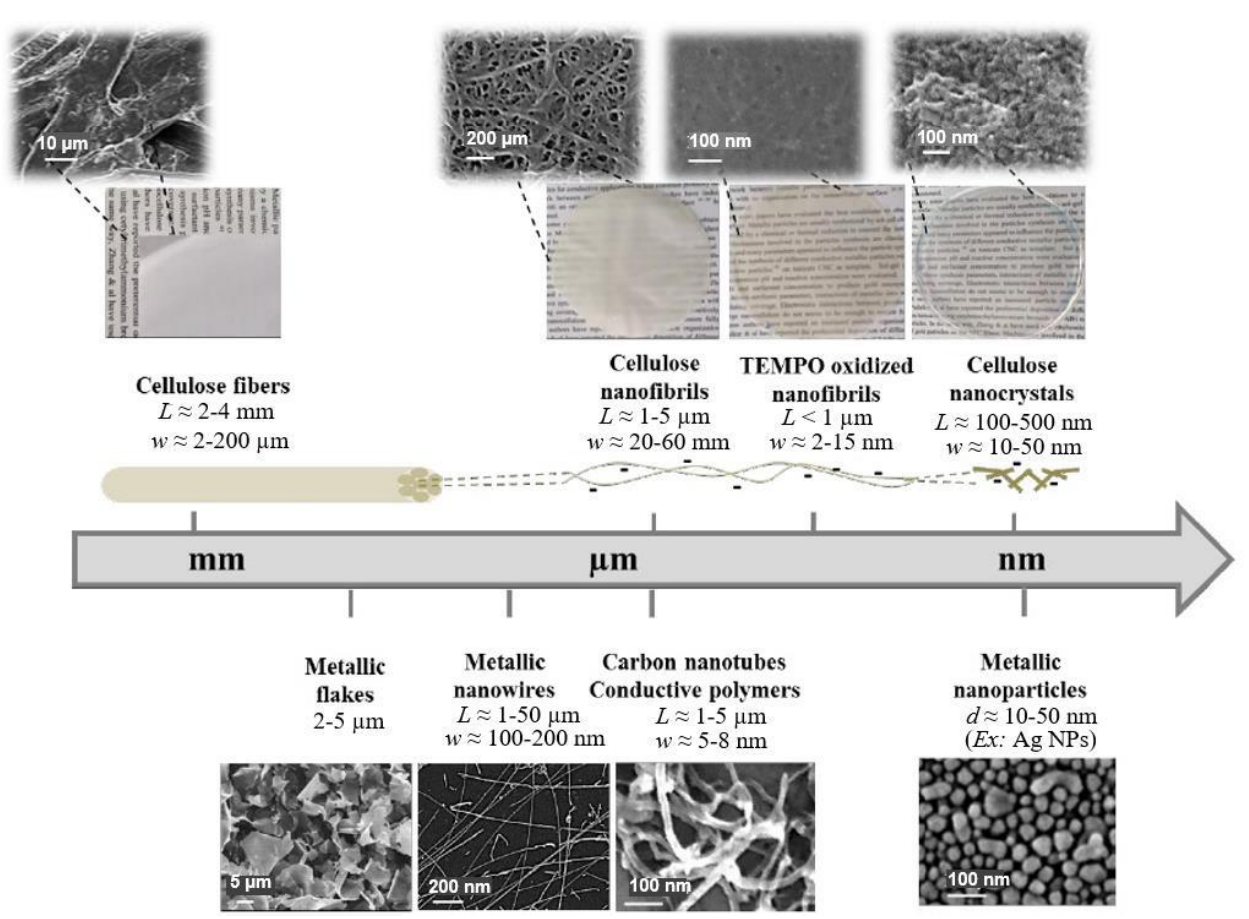
Figure 16. Schematic length-scale representation of networks obtained with different cellulosic materials ( up ) compared to specific dimensions of different conductive particles ( down ). Reprinted with permission from [82]. Copyright 2016: RSC.